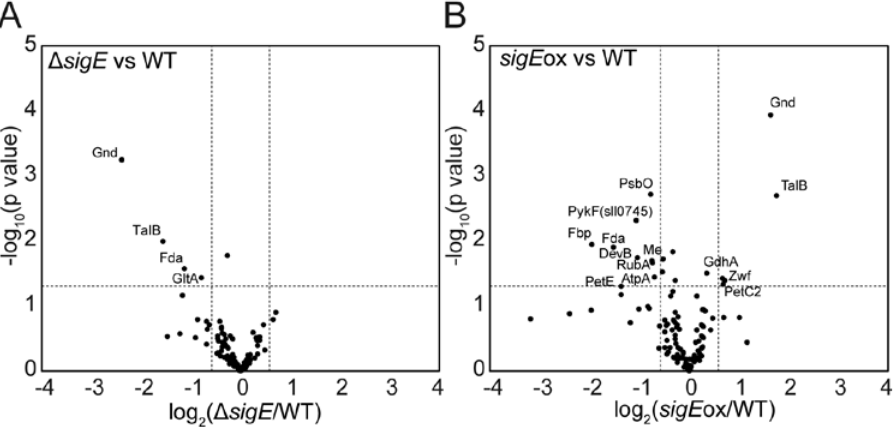
Figure 4. Volcano plot for finding proteins whose abundances were significantly changed in terms of both two-sided Student’s t -test ( α 0.05) and the fold increase (>1.5 and <0.67). ( A ) Δ sigE vs. WT. ( B ) sigE ox vs. WT. Values are means of three independent experiments.